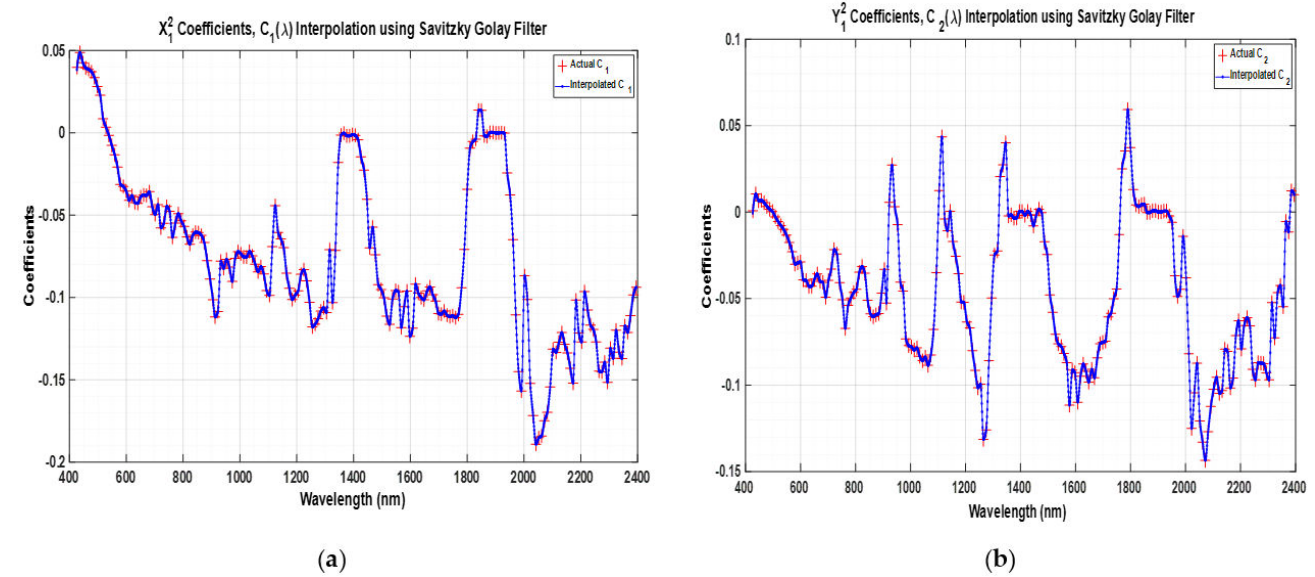
Figure 5. Interpolated ( a ) X 12 coefficients, C 1 ( λ ) and ( b ) Y 12 coefficients, C 2 ( λ ) . Figure 6a,b represents the interpolated hyperspectral profile of X 2 coefficients, C 3 ( λ ) and Y 2 coefficients, C 4 ( λ ) respectively using the filter. The X 12 , Y 12 coefficients had shown more significance in the model manifesting higher values than, X 2 , Y 2 coefficients. As X 2 , Y 2 were structured as linear components, they had less significance in the model with a lower value. Figure 7 demonstrates the intercept, C 0 ( λ ) of the BRDF model which equals to the ρ h ( λ ) parameter. The ρ h ( λ ) was represented as the single hyperspectral profile of over Libya 4 for 196 bands.